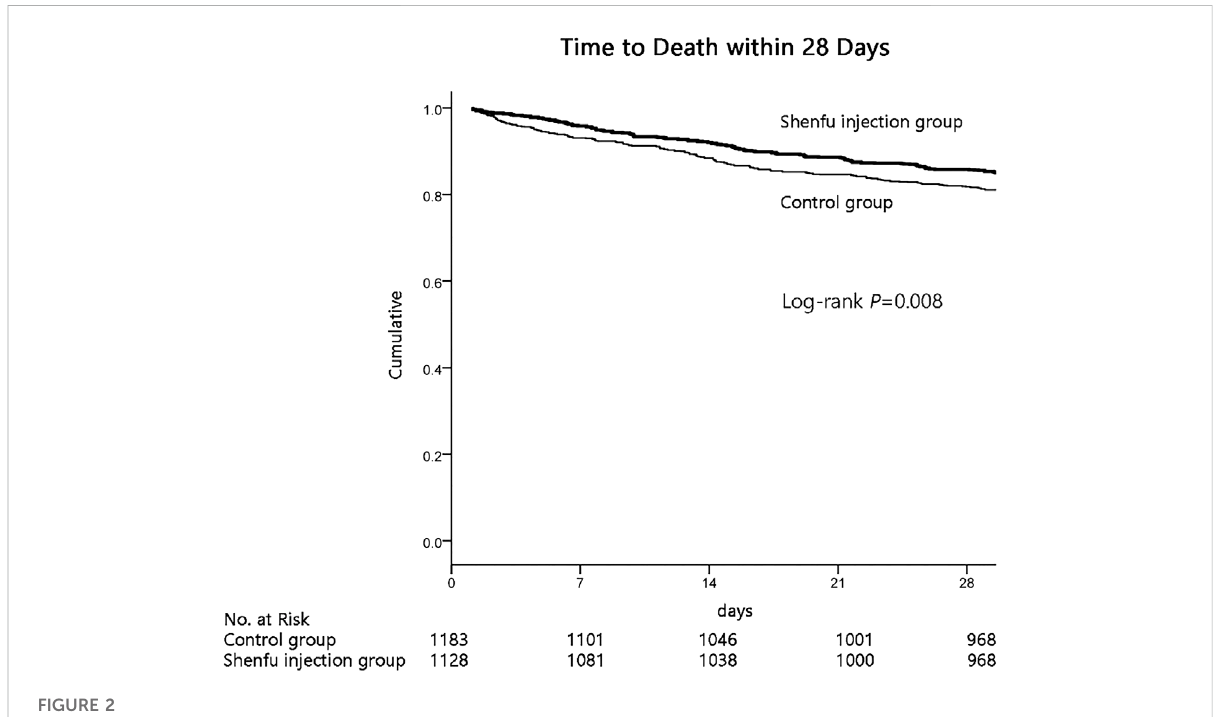
FIGURE 2 Kaplan-Meier graph of 28 days survival probability in two group.